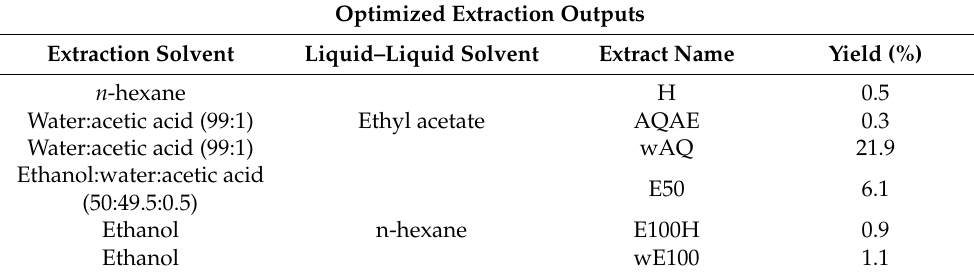
Table 1. Yield of extraction (%) of the six fractions of Undaria pinnatifida obtained in the optimized